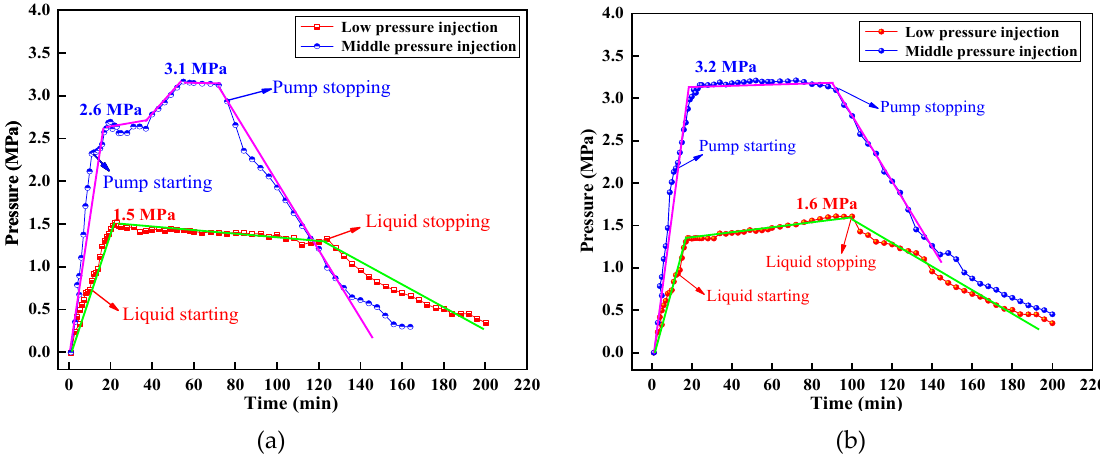
Figure 7. The pressure change trend during injection ( a ) The first injection process and ( b ) The second injection process. Table 4. Main technical indicators of L-CO 2 injection.